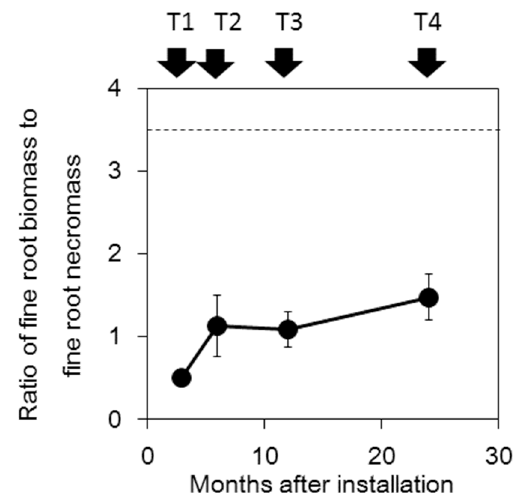
Figure 3. Ratio of fine root biomass to fine root necromass inside the cores at T1 to T4. Standard errors are indicated ( n = 3). Dashed line indicates the ratio of fine to dead root biomass outside the cores (3.47 ± 0.42).